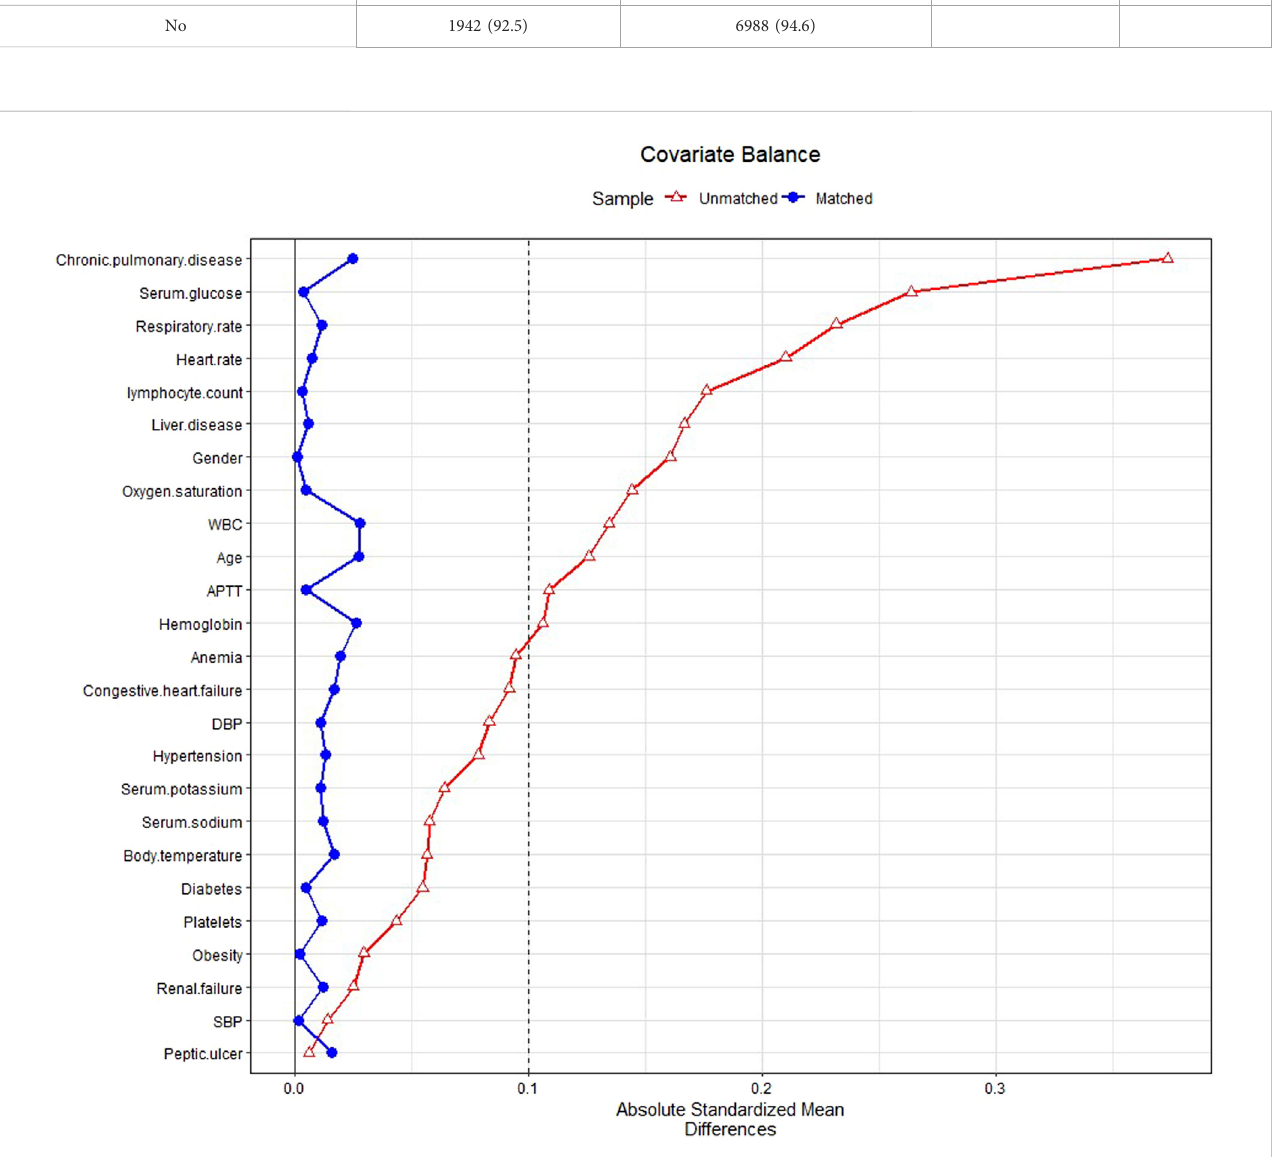
FIGURE 2 Standardized mean difference (SMD) of variables before and after propensity score